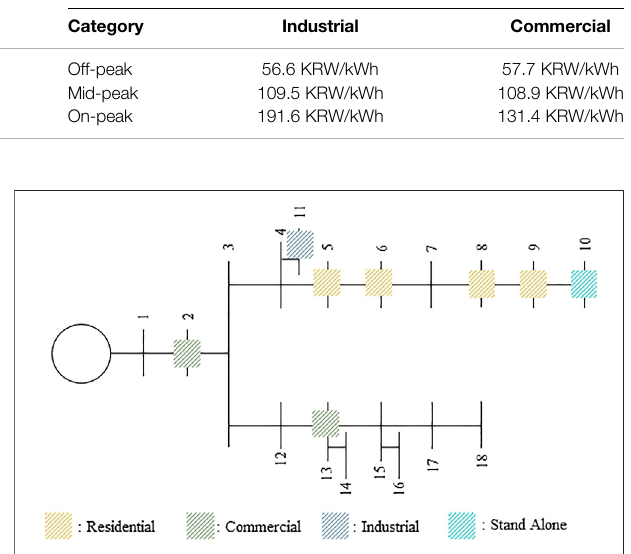
TABLE 1 | Electricity tariff Structure.